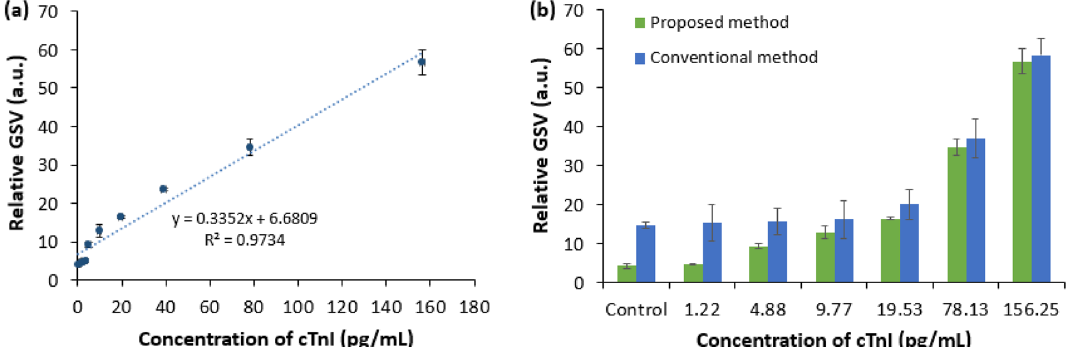
Figure 2. Relative GSV for ( a ) various concentrations of cTnI using ELISA procedures with the proposed microfluidic device, and ( b ) a comparison of the control signal and LOD of the proposed method with those of a conventional method, for six different levels of cTnI. The error bars represent ± standard deviation of n = 3 samples.